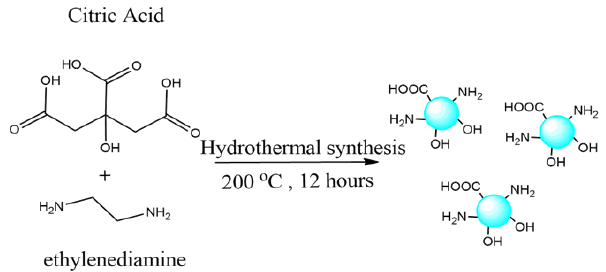
Figure 1. Synthesis of